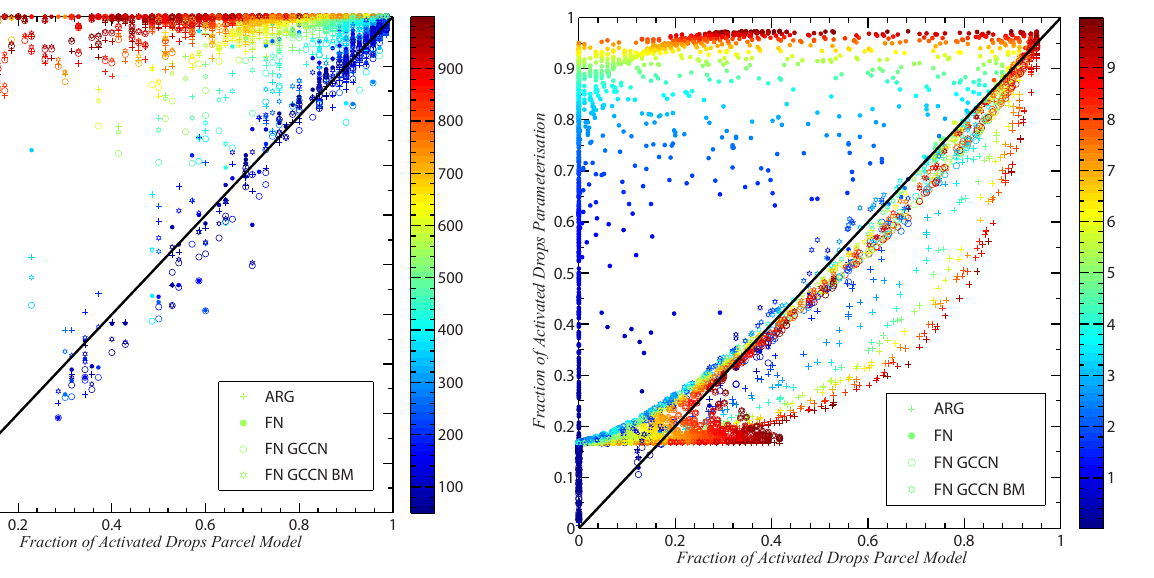
Figure 3. Results from 1500 runs with a bimodal aerosol size distri- bution. Only the median diameter of aerosol in the second mode and updraft velocity were changed between runs. Symbols are coloured by updraft velocity, ms − 1 , see colour bar. For initial conditions and parameter ranges see Tables 1 and 2